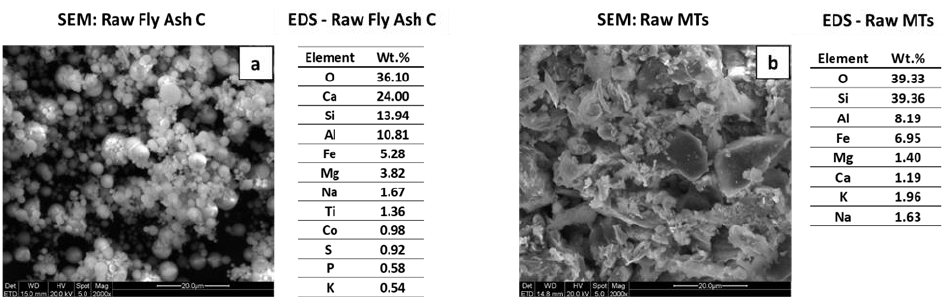
Figure 3. SEM and EDS semiquantitative chemical analyses of the precursor materials (wt.%). ( a ) raw FAc, ( b ) raw MTs.